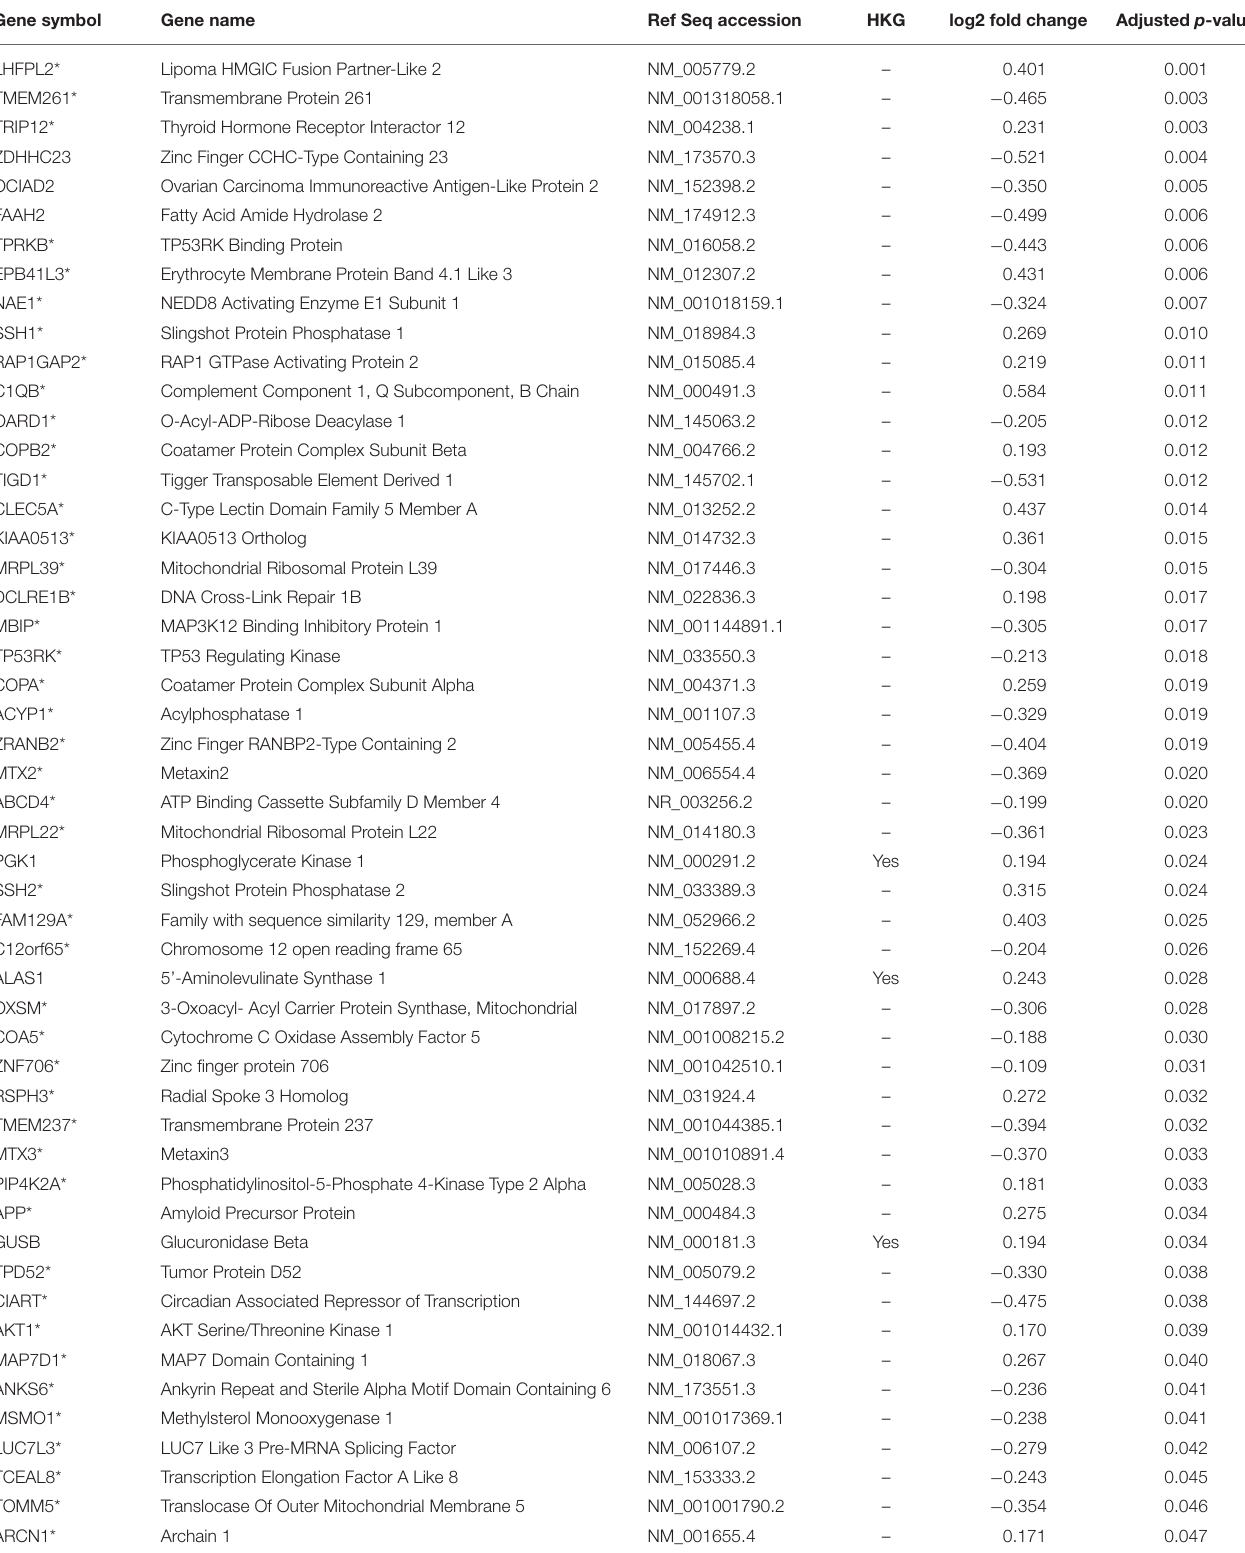
TABLE 3 | Genes included in the structure, function, and development